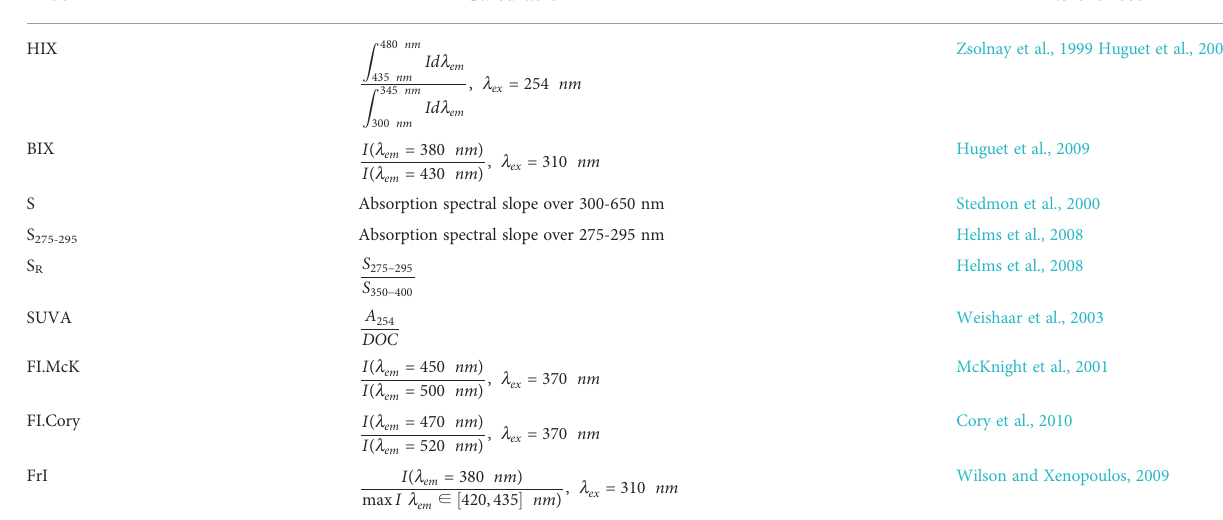
TABLE 1 Spectroscopic indices for identi fi cation the sources of organic